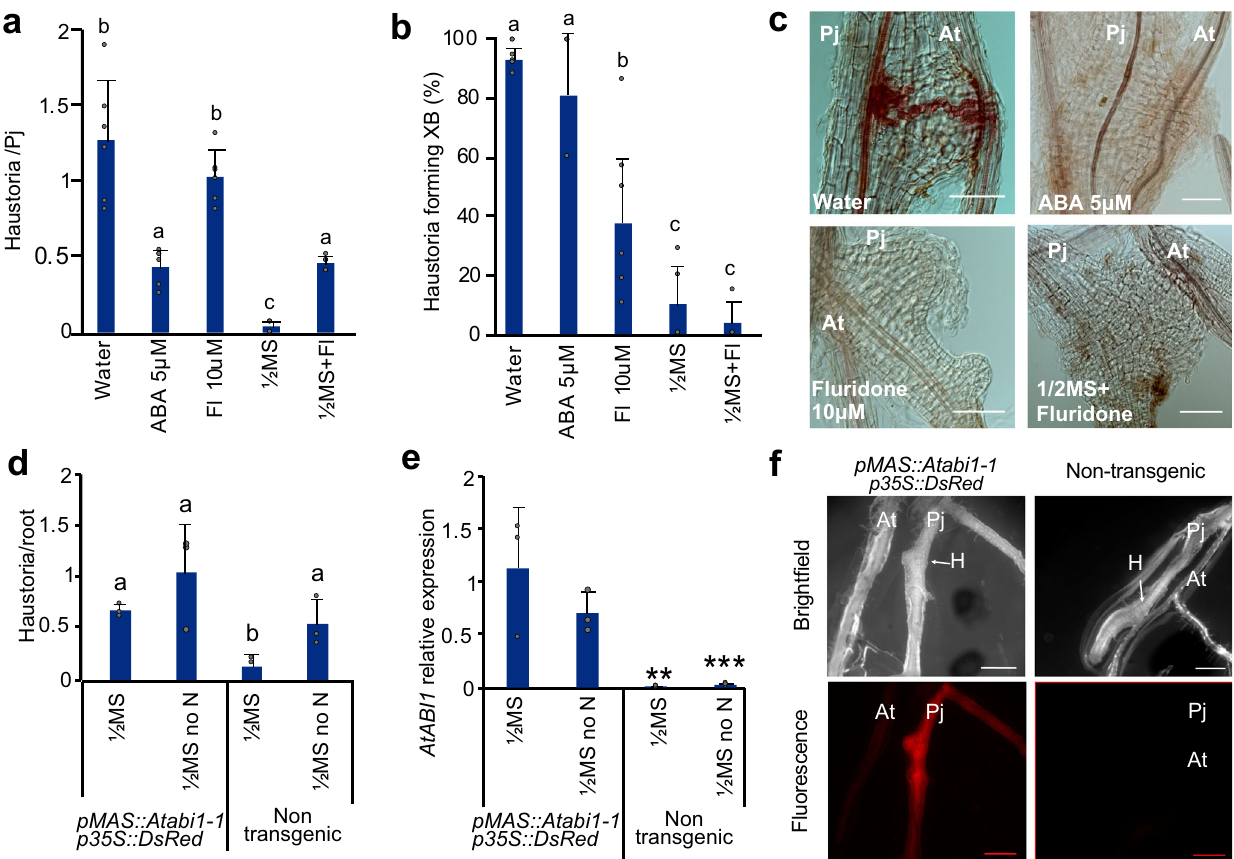
Fig. 6 ABA represses P. japonicum haustoria formation. a , b Haustoria number per P. japonicum seedling and xylem bridge formation percentage in in vitro Arabidopsis (Col-0 ) infections treated with ABA (6 replicates), fl uridone (Fl) (6 replicates), ½MS (6 replicates), ½MS no N (6 replicates) or ½MS + fl uridone (5 replicates) (mean ± SD, n = 20 plants per treatment per replicate). c Representative images of P. japonicum haustoria during Arabidopsis in vitro infection with ABA, fl uridone, ½MS or ½MS + fl uridone. Scale bars 50 μ m. 5 replicates. d Haustoria number per P. japonicum hairy roots overexpressing Atabi1-1 in in vitro infection assay with Arabidopsis Col-0 and ½MS or ½MS no N (mean ± SD, pMAS::Atabi1-1 n = 19 for ½MS and n = 24 for ½MS no N treatments, non-transgenic n = 30 for ½MS and n = 29 for ½MS no N treatments). e Expression levels of Atabi1-1 in fl uorescent and non- fl uorescent hairy roots analyzed by qPCR (mean ± SD, n = 3 roots per treatment, 3 replicates). f Representative images of P. japonicum hairy roots in the ½MS no N treatment in bright fi eld and red fl uorescence fi elds, the haustorium (H) is denoted by an arrow, scale bars 500 μ m. 3 replicates. a , b , d Different letters represent P < 0.05, one-way ANOVA followed by Tukey ’ s HSD test. e Asterisks represent * P < 0.05, ** P < 0.001, *** P < 0.0001 compared to ½MS transgenic roots, Student ’ s t test, two tailed. Source data